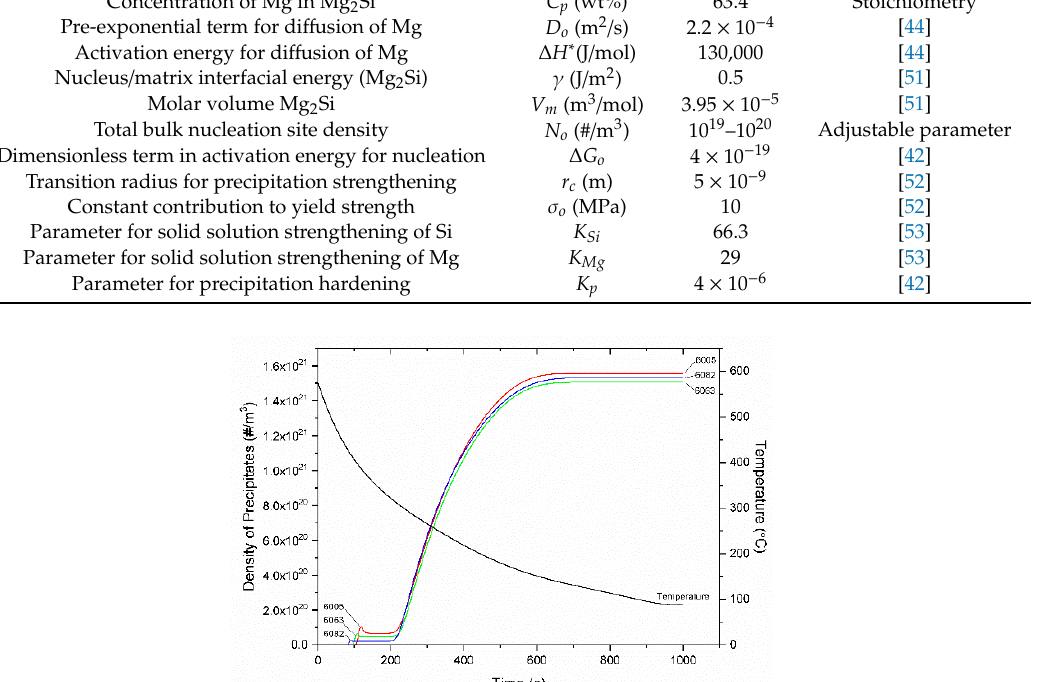
Figure 12. Variation of the number density of Mg 2 Si precipitates with time during homogenization cooling for 6063, 6005 and 6082 alloys. The cooling curve is also indicated.